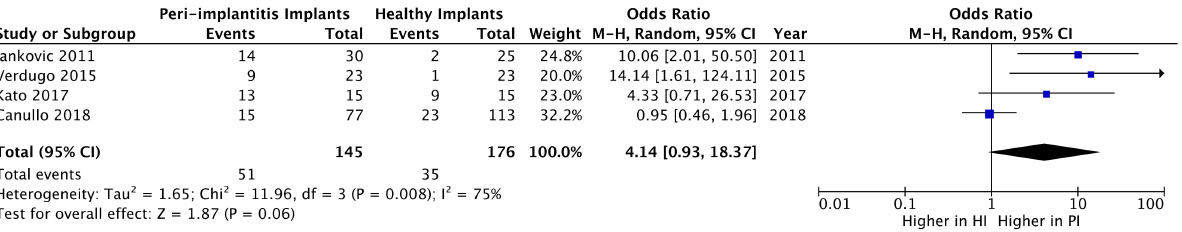
Figure 2. Forest plot of the prevalence of Epstein–Barr virus (EBV) in peri-implantitis implants versus healthy